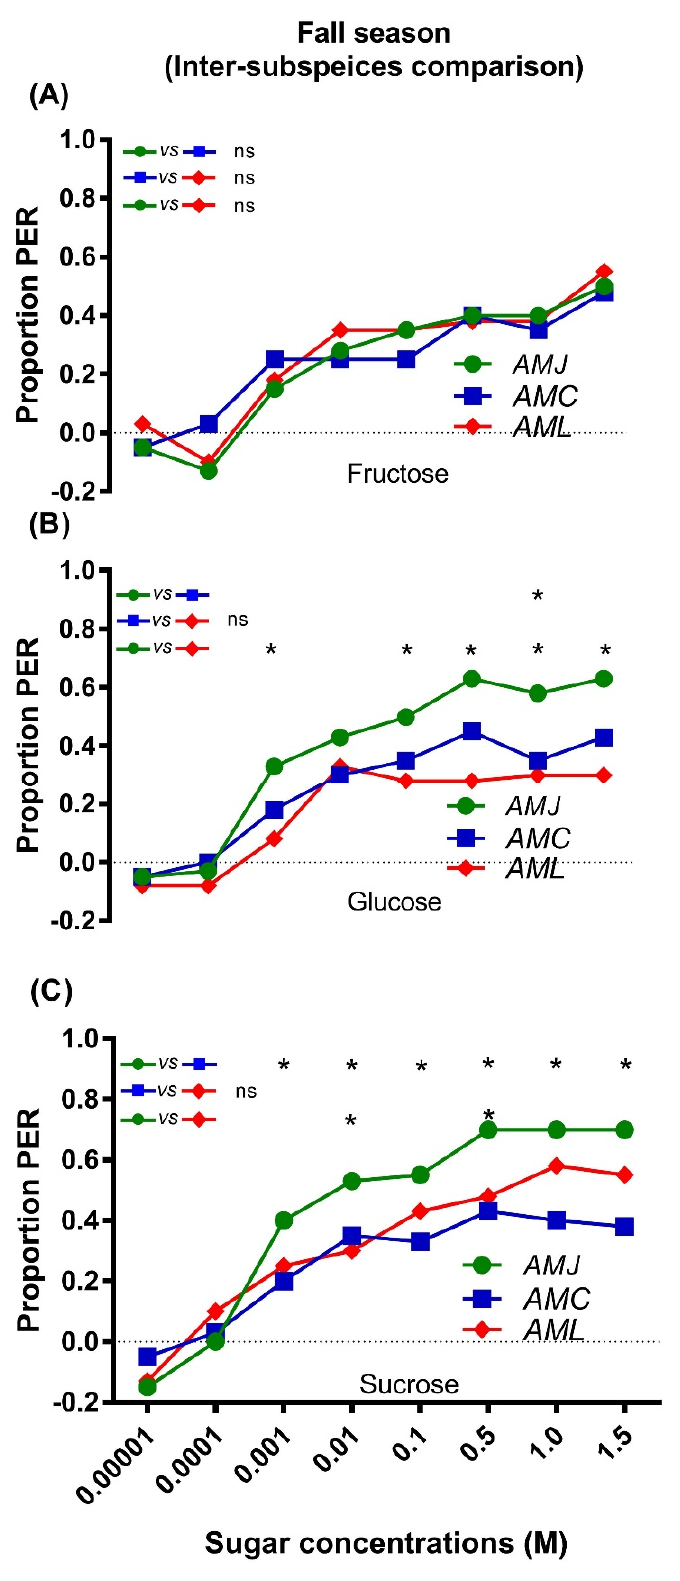
Figure 5. Comparison of the response to fructose ( A ), glucose ( B ) and sucrose ( C ) among honey bee subspecies during the fall season. Asterisks indicate the significant difference ( x 2 or Fisher’s exact test * p < 0.05) between the responses of honey bee subspecies ( AMJ vs. AMC , AMC vs. AML and AMJ vs. AML ) to different concentrations of each sugar type.